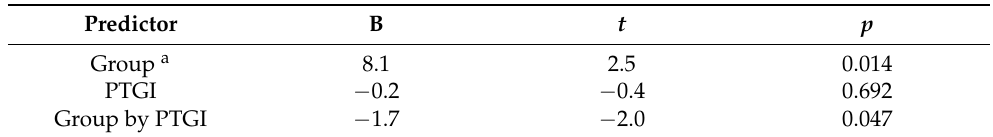
Table 2. Regression analysis for testing the moderating effect of posttraumatic growth on group differences in postnatal depressive symptomatology.